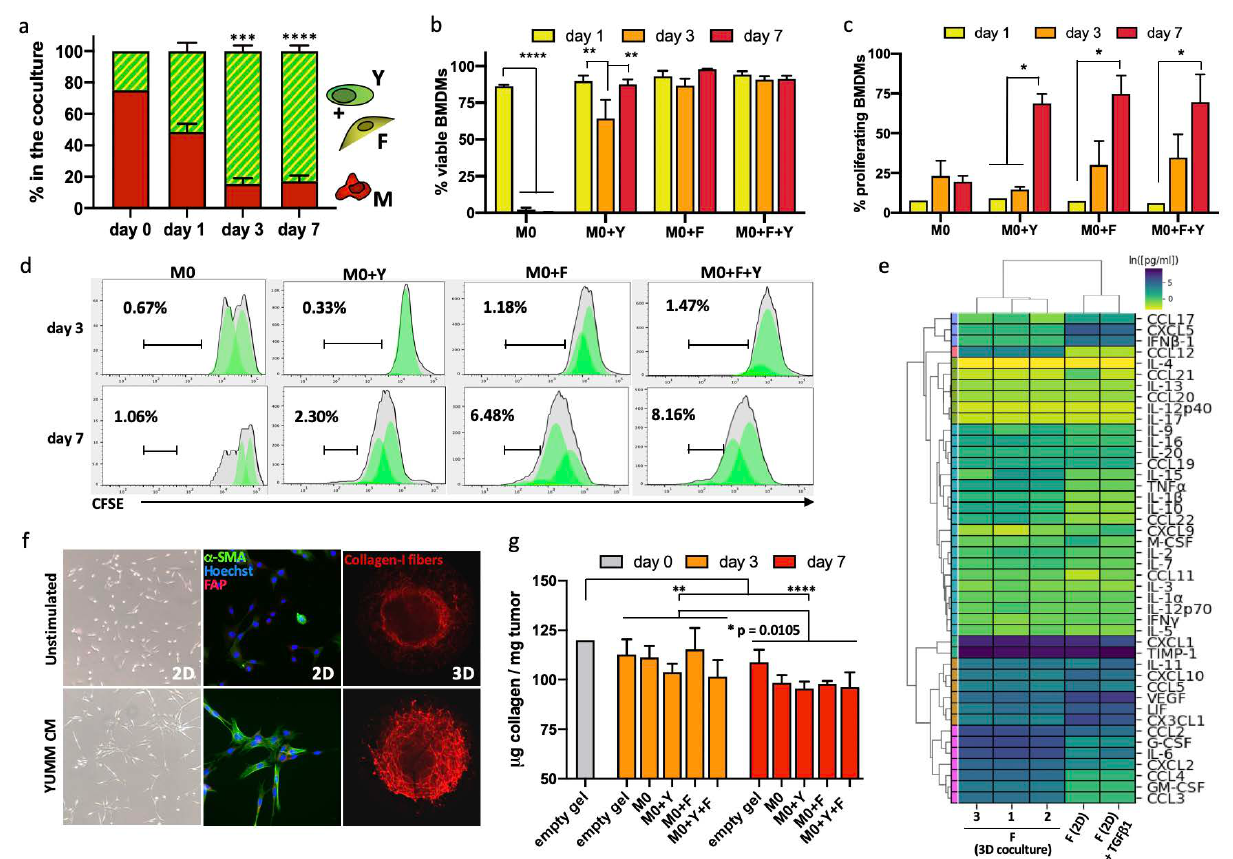
Figure 3. Rapid functional cell activation after early interactions in the 3D melanoma TME. ( a ) Evolution of the composition of cell types in 3D cultures over time, starting from a 12:3:1 M-F-Y ratio (d1 n = 4, d3 n = 5, d7 n = 8). ( b ) M0 BMDM survival in 3D cultures over time. Viability of macrophages was assessed after being cultured alone or in combination with the other cell components, at d1, d3 and d7 ( n = 3). ( c ) M0 BMDM proliferation in 3D cultures overtime. We analyzed cell divisions of macrophages after CFSE staining, and considered in the proliferating fraction all cells that had undergone at least one division cycle ( n = 2). ( d ) Representative histograms of macrophage proliferation from all the co-culture conditions, gates are highlighting the high proliferative subpopulations (over two divisions at each timepoint). ( e ) Hierarchical clustering of 43-plex secretion profile analysis of 3T3MEF fibroblasts. We compared secretion in resting cells with TGF- β 1 stimulation and fibroblast from 7d 3D co-cultures. ( f ) Activation of the 3T3MEF cell line by YUMM melanoma cells. Fibroblasts were stimulated with YUMM conditioned media (CM), and we observed morphological changes under the light microscope and activation through the expression of α -SMA. When cultured in 3D cultures, we assessed fibroblast functional activation in a stained collagen pulling assay. ( g ) Quantification of total soluble collagen-I in the M0 3D cultures, at d3 and d7, compared to the initial collagen-I added in each. A control well with no cells was kept as a control of the quantifiable soluble collagen-I ( n = 4). * p < 0.05, ** p < 0.01, *** p < 0.001, **** p <